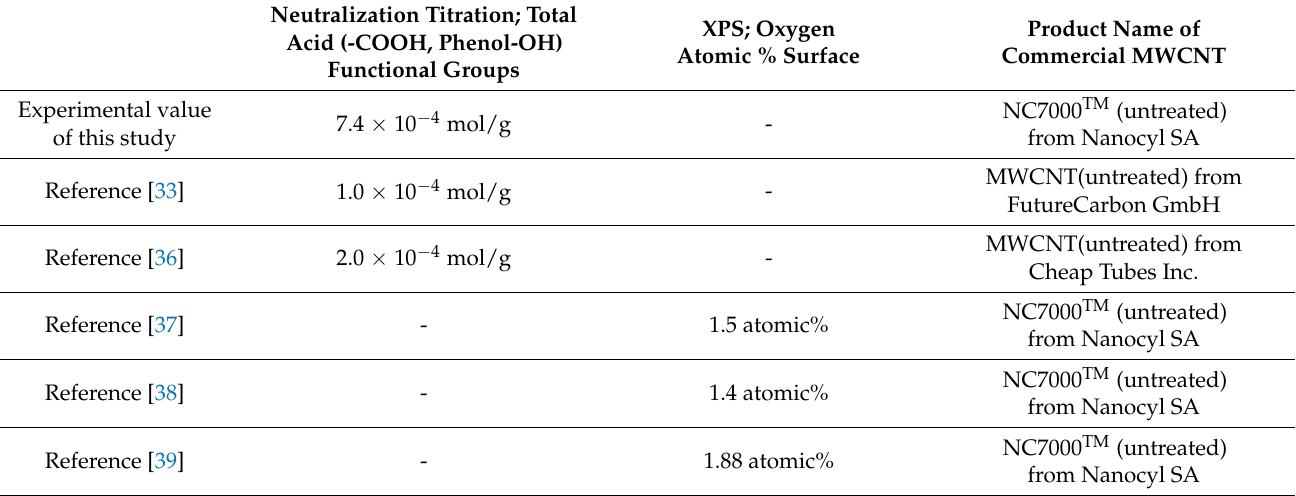
Table 4. Experimental evidence and the former results from the references [33,36–39] about the total acid groups and the oxygen atomic percentage from the neutralization titration and XPS, respectively, using the commercially available untreated